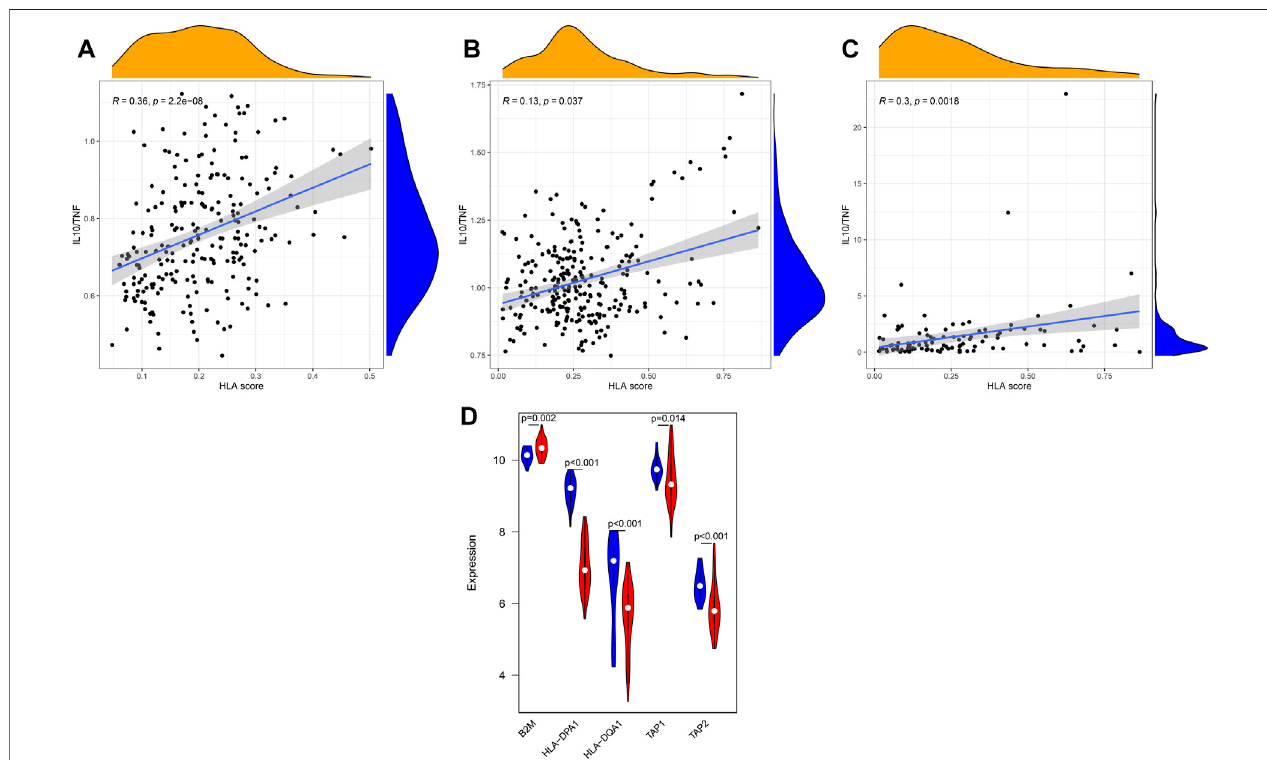
FIGURE12| CorrelationbetweentheHLAclassi fi erandtheratioofIL10/TNFinmultipletranscriptomedatasets. (A) GSE65682datasets. (B) GSE63042datasets. (C) E-MTAB-4421 datasets. (D) Comparison of gene expression levels of fi ve HLA genes between controls and sepsis samples via qRT-PCR. Red indicates sepsis, while blue indicates